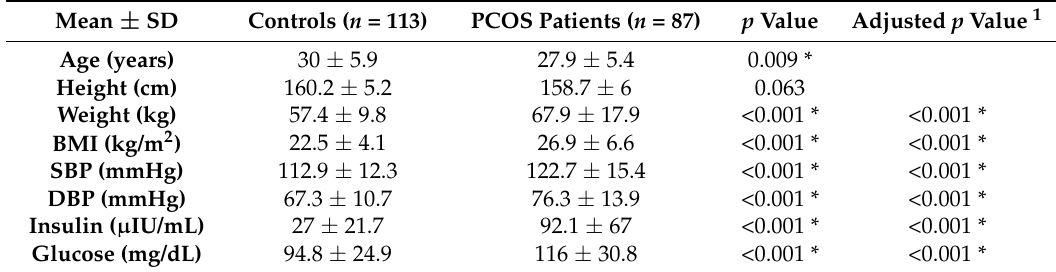
Table 1. Baseline characteristics of the controls and polycystic ovary syndrome (PCOS) patients. Mean ± SD Controls ( n = 113) PCOS Patients ( n = 87)